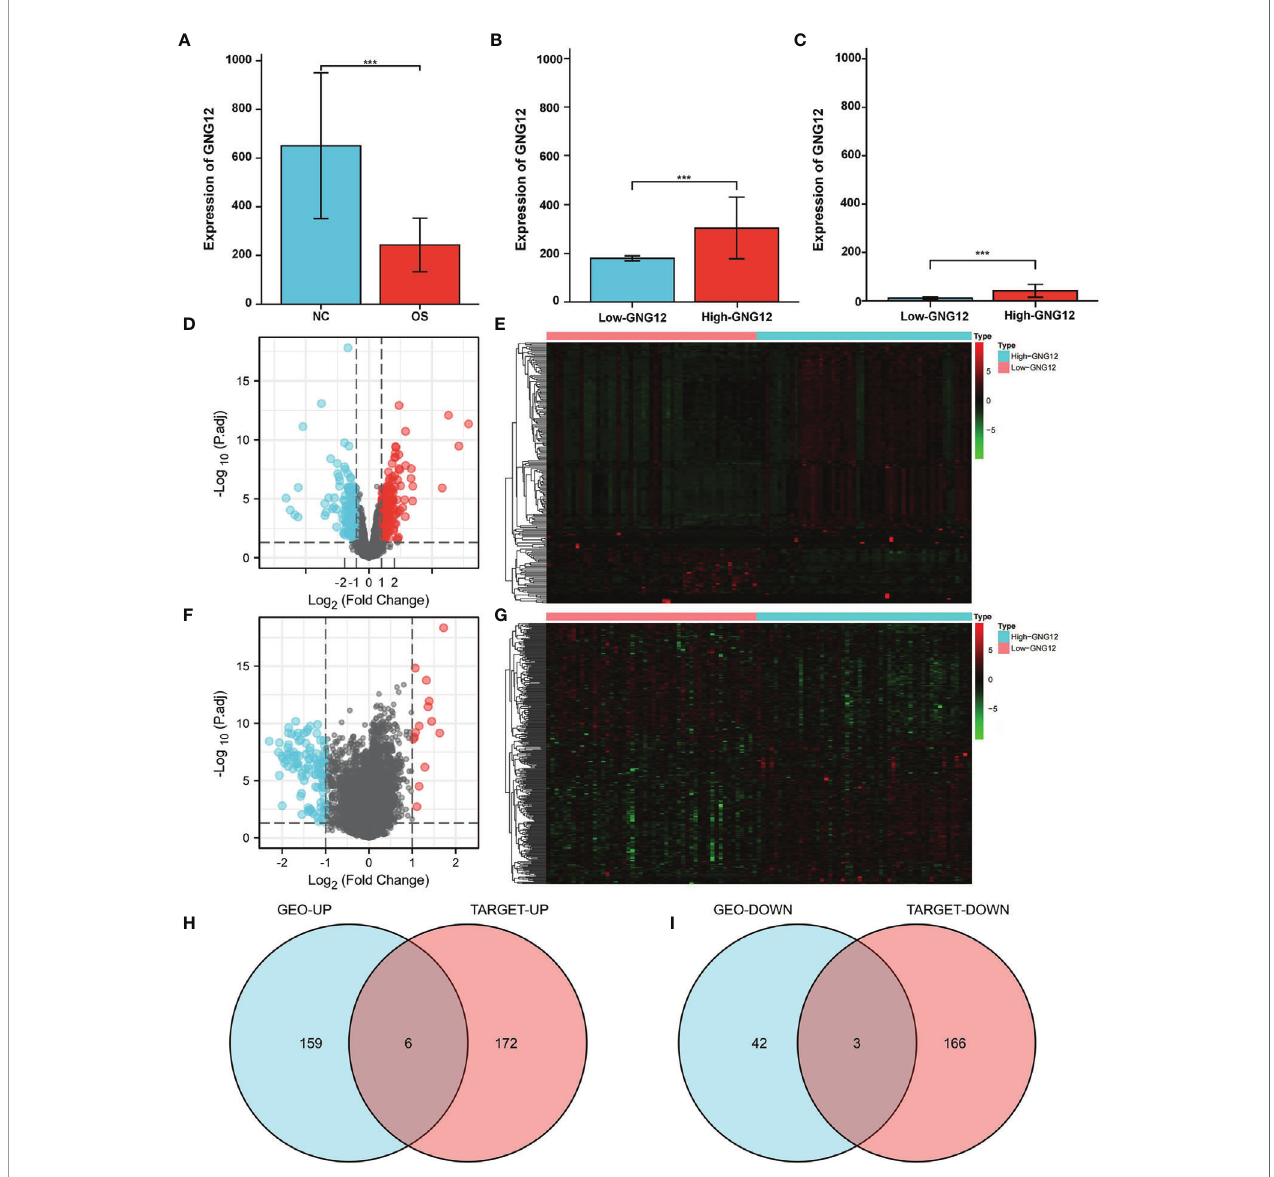
FIGURE 1 | GNG12 and coexpressed gene difference analysis. (A) Compared with normal tissues, GNG12 is signi fi cantly lower expressed in tumor tissues. (B) In GSE42352 cohort, the expression level of GNG12 in low/high GNG12-expression groups. (C) In TARGET cohort, the expression level of GNG12 in low/ high GNG12 expression groups. (D) The median expression of GNG12 in 103 osteosarcoma samples in the GSE42352 data set was divided into high and low expression groups, and the signi fi cantly different genes between the two groups were displayed in the form of a volcano graph. (E) A heat map showing the signi fi cantly different genes between the two groups of the GSE42352 data set. (F) GNG12 was used in the median expression values of 101 osteosarcoma samples in the TARGET data set divided into high and low expression groups, showing the signi fi cant difference genes between the two groups in the form of volcano maps. (G) The TARGET data set shows the signi fi cant difference genes between the two groups in the form of a heat map. (H) Venn diagram of the intersection of upregulated DEGs in the GEO and TARGET cohort. (I) Venn diagram of the intersection of downregulated DEGs in the GEO and TARGET cohort. ***p <